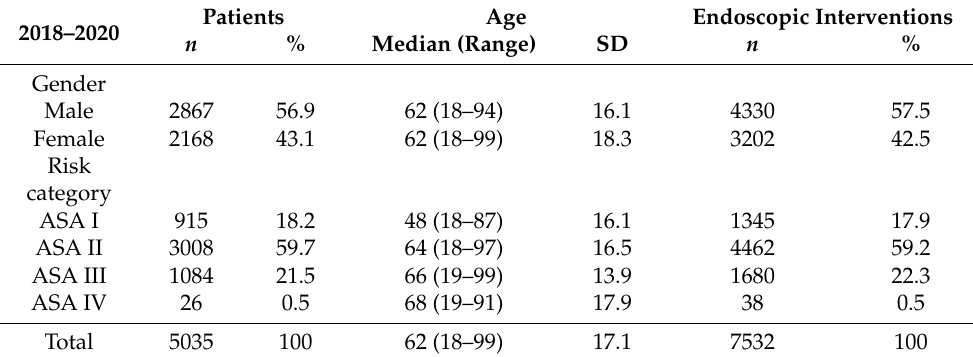
Table 1. Patient